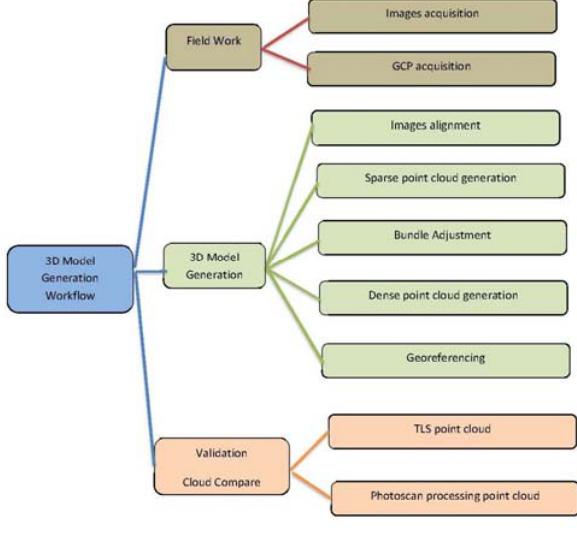
Figure 1: 3D model workflow